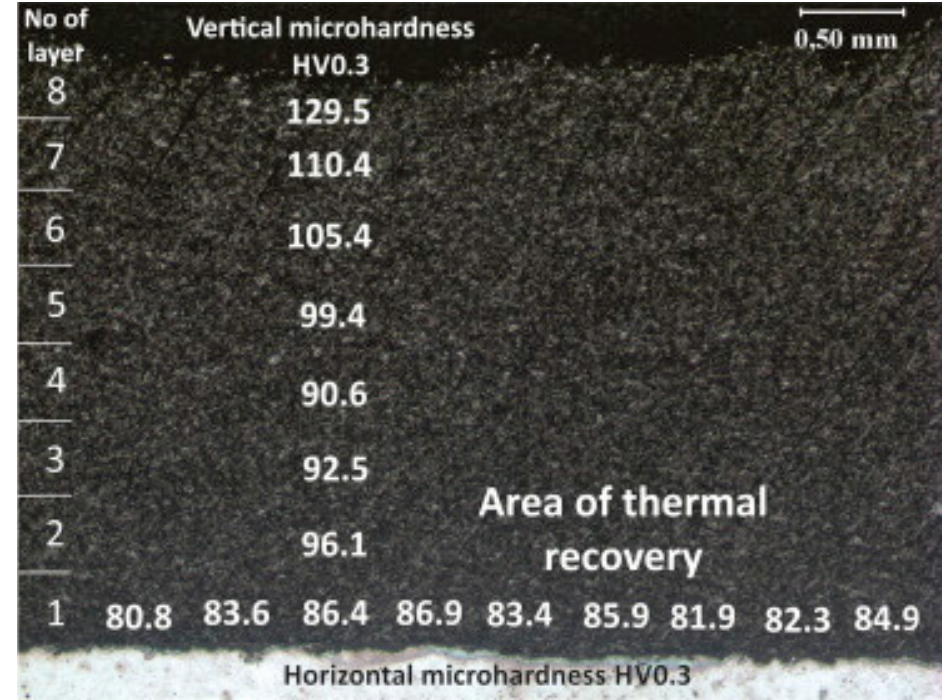
Figure 16. Microhardness distribution in 3mm thick Al-Al 2 O 3 composite LPCS coating . Reprinted with permission from [101]. Copyright 2016 Elsevier.